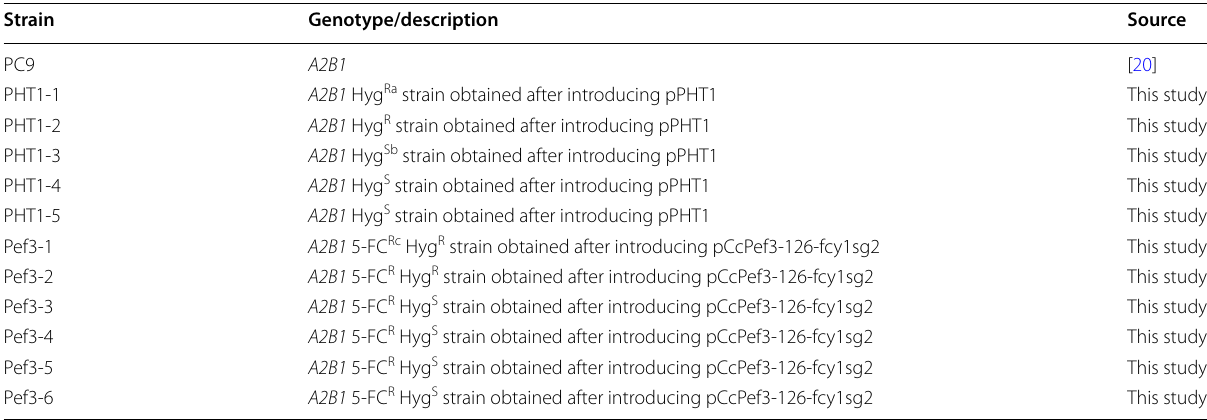
a Hyg R indicates hygromycin B-resistant strains b Hyg S indicates a hygromycin B-sensitive strain c 5-FC R indicates 5-fluorocytocine-resistant strain